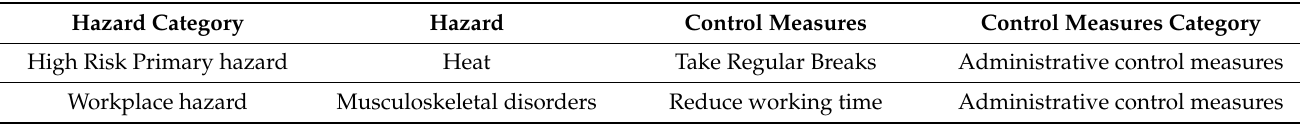
Table 8. The result of Query 4, in a tabular